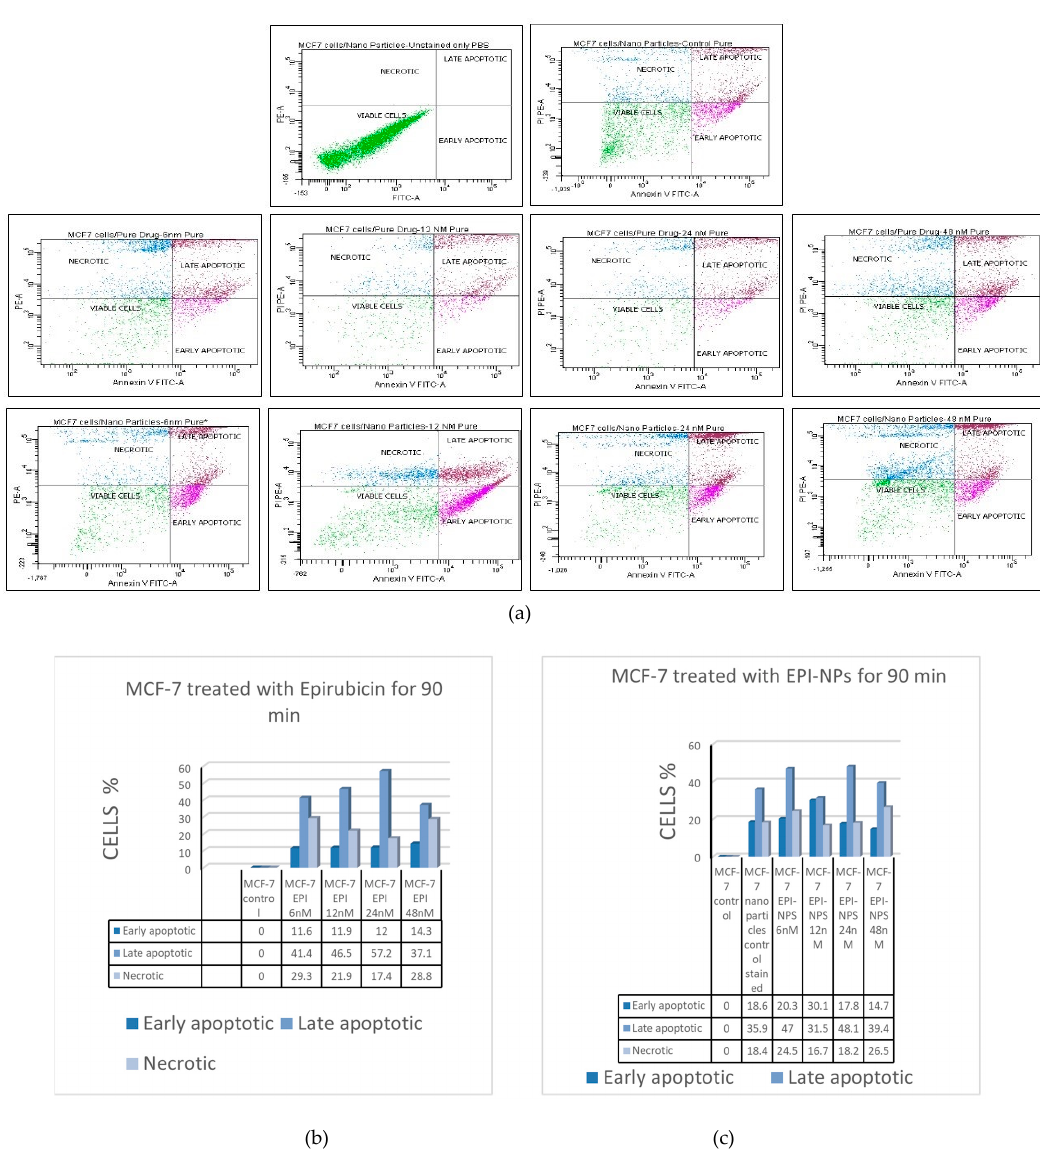
Figure 8. ( a ) Flow cytometry results for MCF-7 cells, incubated with 6 nM, 12 nM, 24 nM and 48 nM EPI and 6 nM, 12 nM, 24 nM and 48 nM EPI-NPS ( b ) column graph representing the percentage of early apoptotic, late apoptotic, and necrotic MCF-7 cells incubated with 6 nM, 12 nM, 24 nM and 48 nM EPI and ( c ) column graph representing the percentage of early apoptotic cells, late apoptotic cells, and necrotic MCF-7 cells incubated with 6 nM, 12 nM, 24 nM and 48 nM EPI-NPs. Flow cytometry was used in this study to evaluate the effect of EPI-NPs on the MCF- 7 cell line and to compare it with the effect of free-form EPI on the same cells. The MCF-7 cells were treated with 6 nM, 12 nM, 24 nM, and 48 nM of EPI-NPs and 6 nM, 12 nM, 24